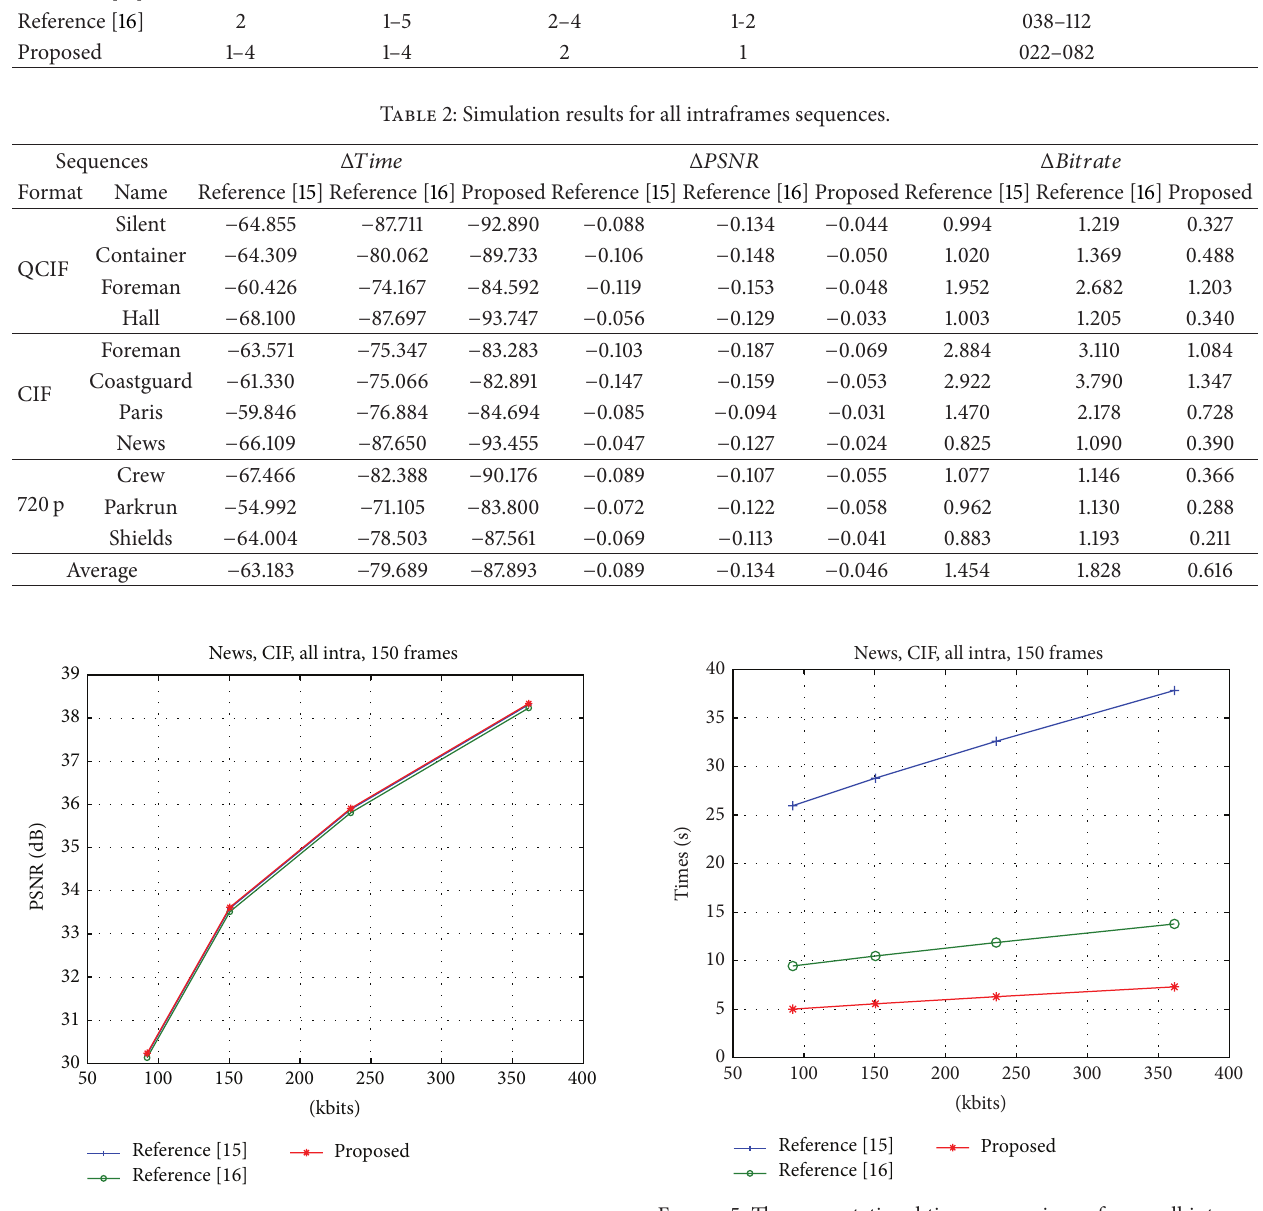
Figure 5: The computational time comparison of news all intrase-